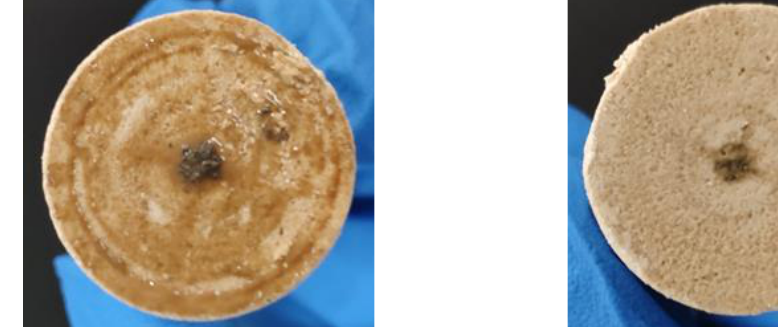
Figure 14. Pressure difference curve before and after damage.